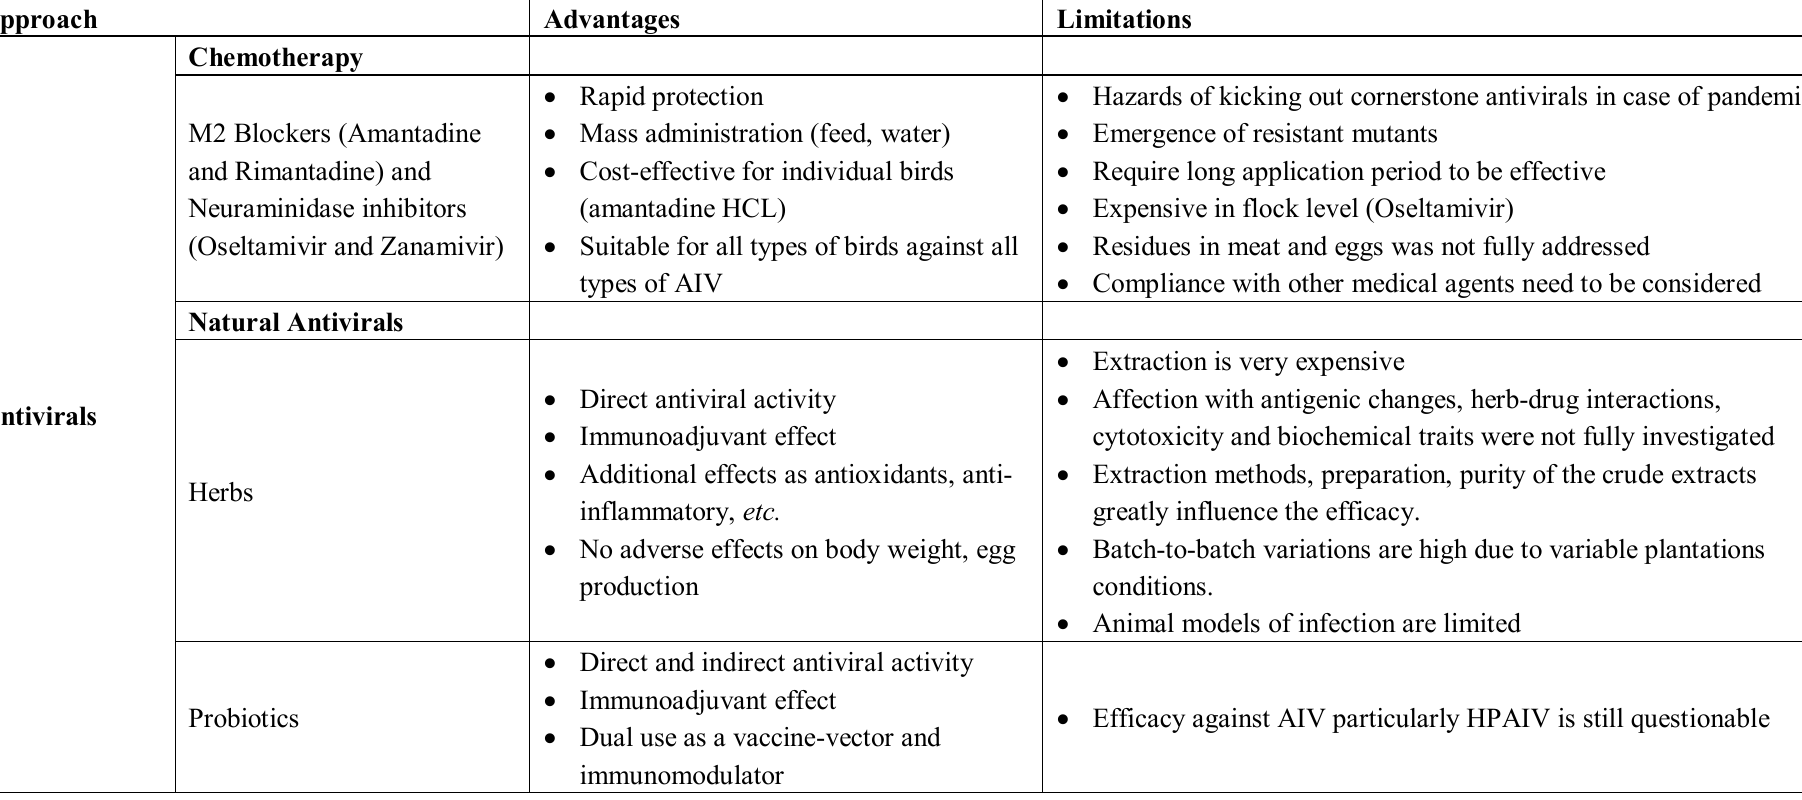
Table 1. Advantages and limitations of different alternative approaches for control of avian influenza viruses in